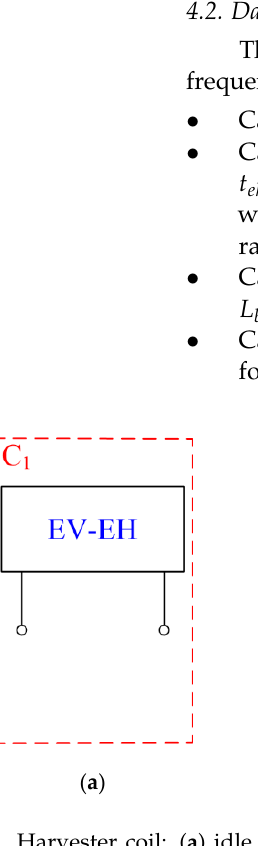
Figure 6. Harvester coil: ( a ) idle run; ( b ) under the load R a ; ( c ) under the load R b L b ; ( d ) under the load R d L d (MR damper coil).